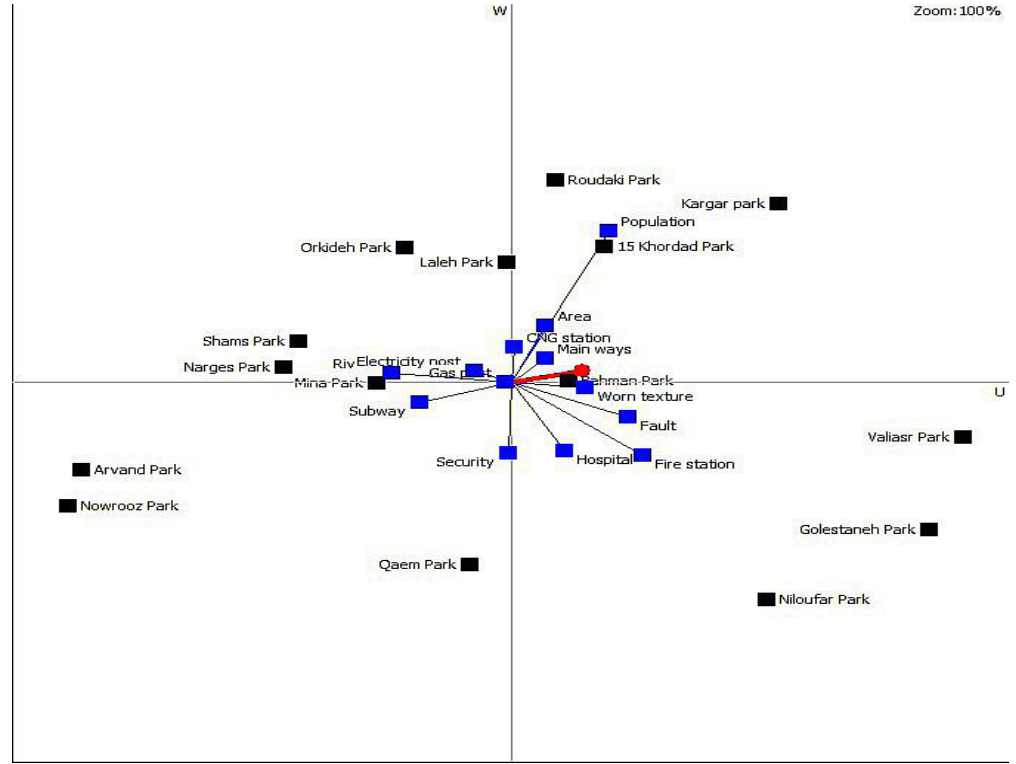
Fig. 5. GAYA diagram of the output of the PROMETHEE.